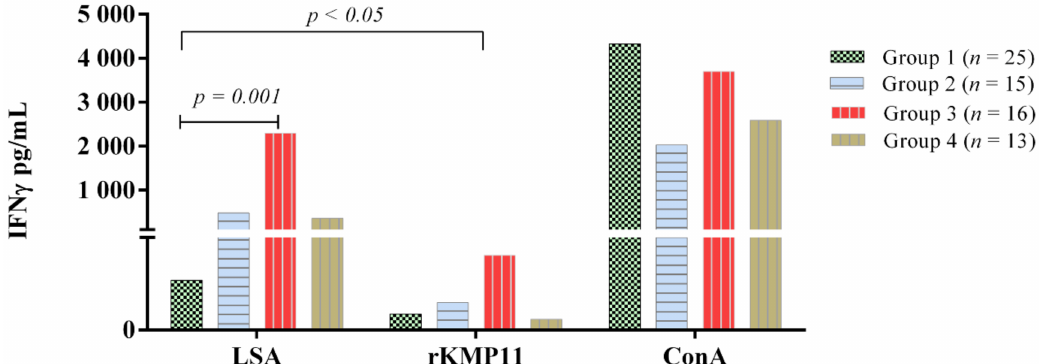
Figure 3. Specific ex vivo IFN- γ concentration after L. infantum , rKMP11 and ConA stimulation in apparently healthy non-infected dogs from a low endemicity area, Asturias, Spain (Group 1), sick dogs from Catalonia, Spain (Group 2), apparently healthy Ibizan hounds from a high endemicity area, Mallorca, Spain (Group 3) and apparently healthy dogs from a high endemicity area, Bari, Italy (Group 4).